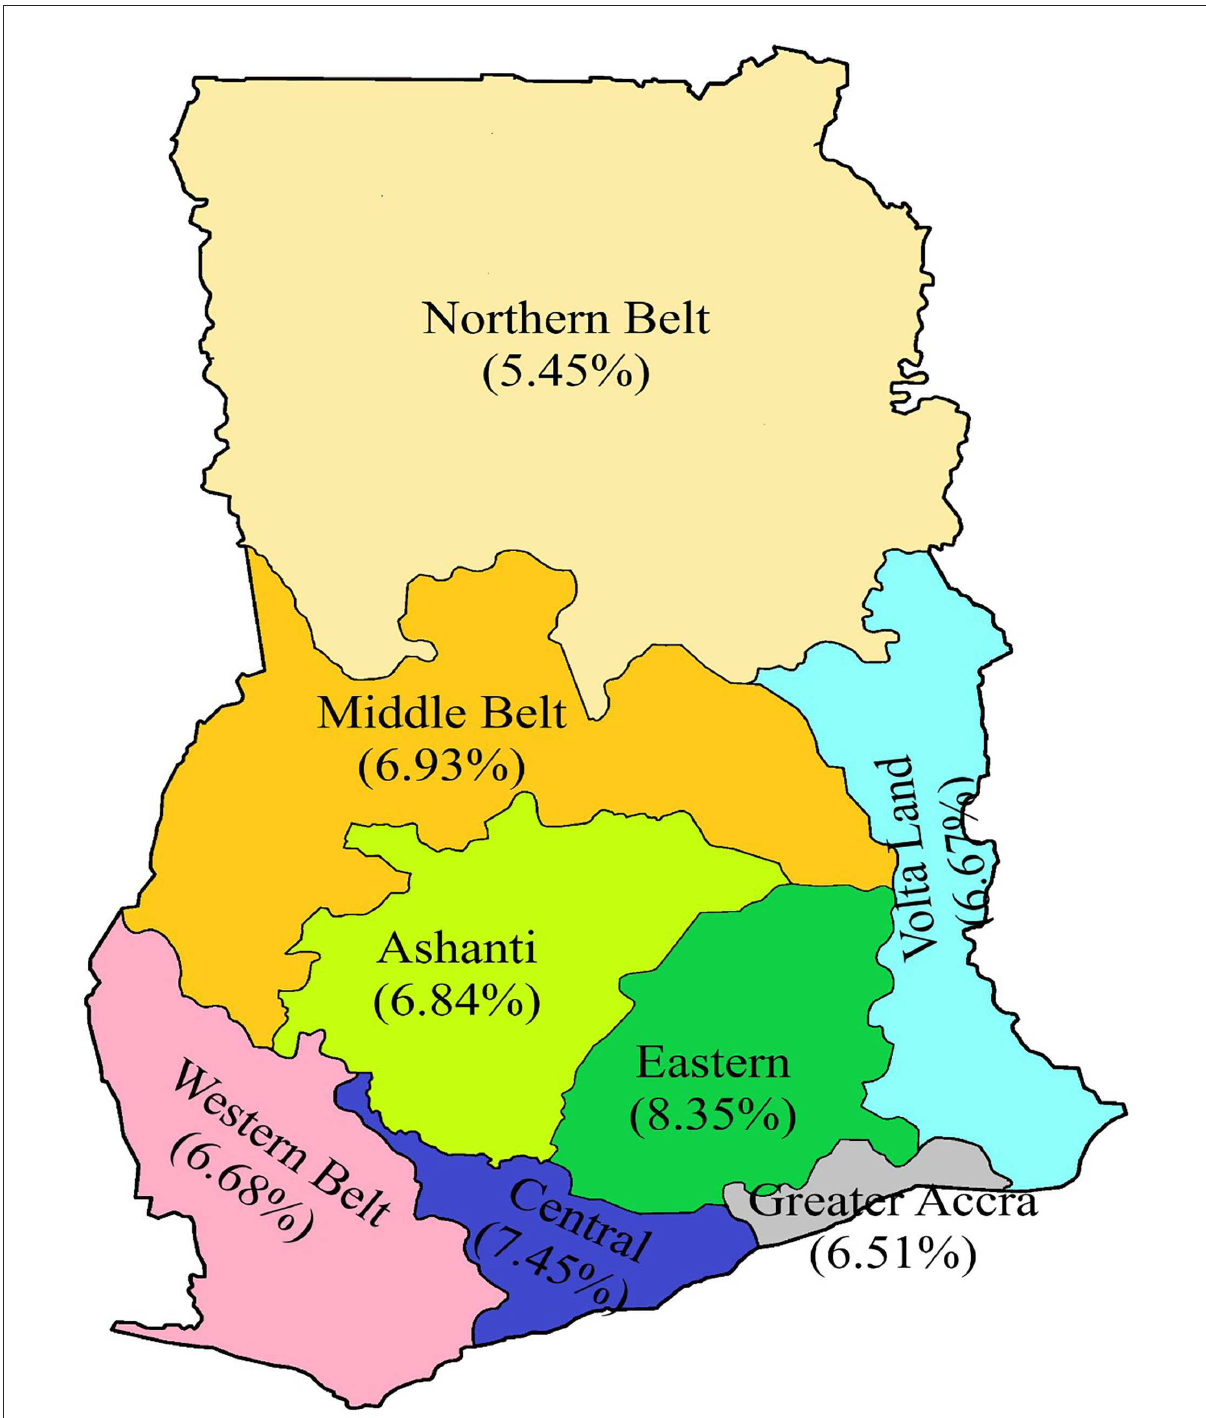
FIGURE1 A revised map of Ghana showing the regional distribution of positivity rate. The Ahafo, Bono East, and Brong Ahafo regions are defined as the Middle belt; the Upper West, Upper East, North East, Savannah, and Northern regions were defined as the Northern belt. The Oti and Volta regions were defined as Volta Land, while the Western North and Western regions were defined as the Western belt. The remaining regions retained their administrative status and